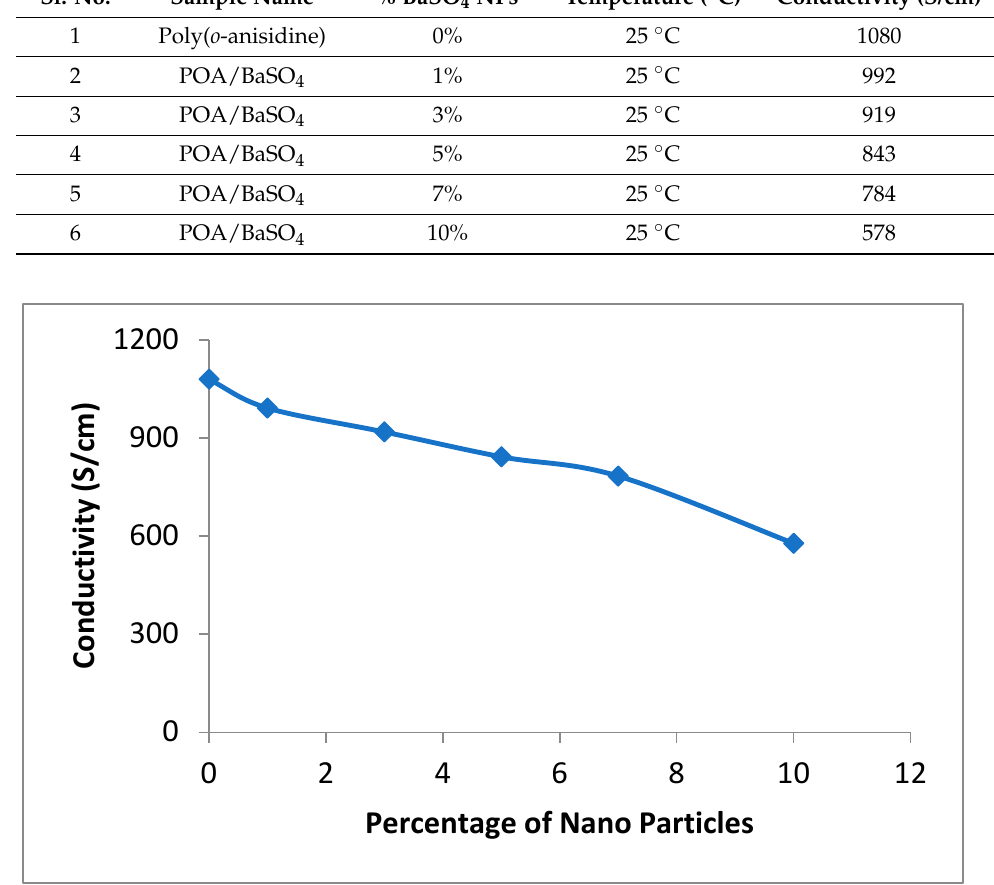
Figure 5. The plot of conductivity and nanoparticles’ percentage relationship.